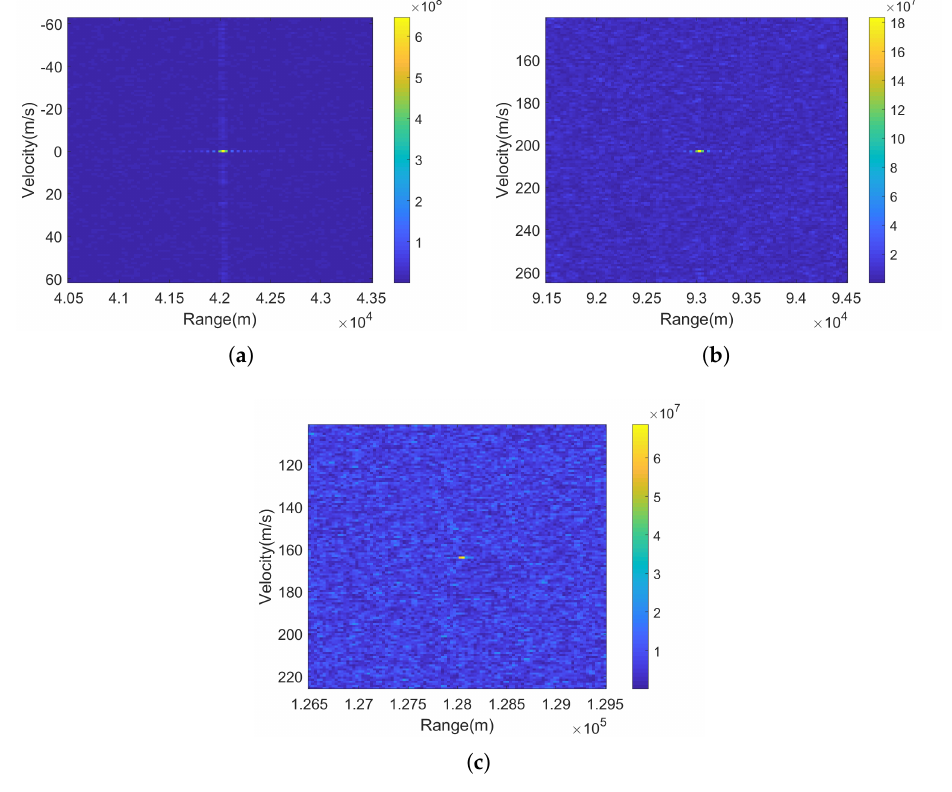
Figure 18. Coherent integration results of three targets. Table 2. Motion parameters of the